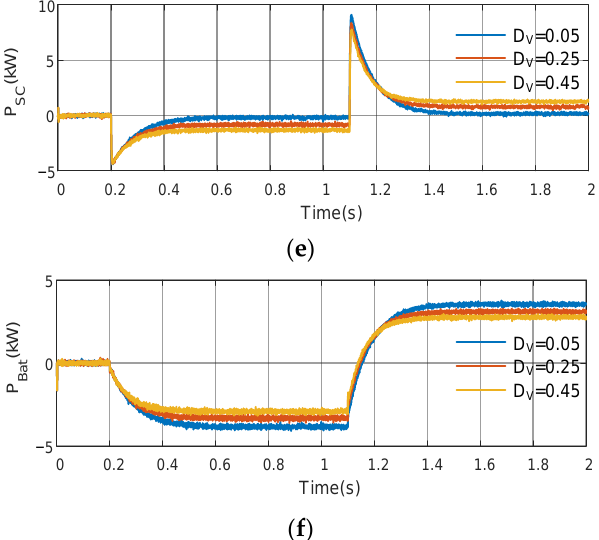
Figure 13. The virtual inertia response of the battery and SC with different J V and D V. ( a ) Magnitude of PCC voltage with D V = 0.05; ( b ) SC output power profile with D V = 0.05; ( c ) Battery output power profile with D V = 0.05; ( d ) magnitude of PCC voltage with J V = 0.1; ( e ) SC output power profile with J V = 0.1; ( f ) battery output power profile with J V = 0.1.